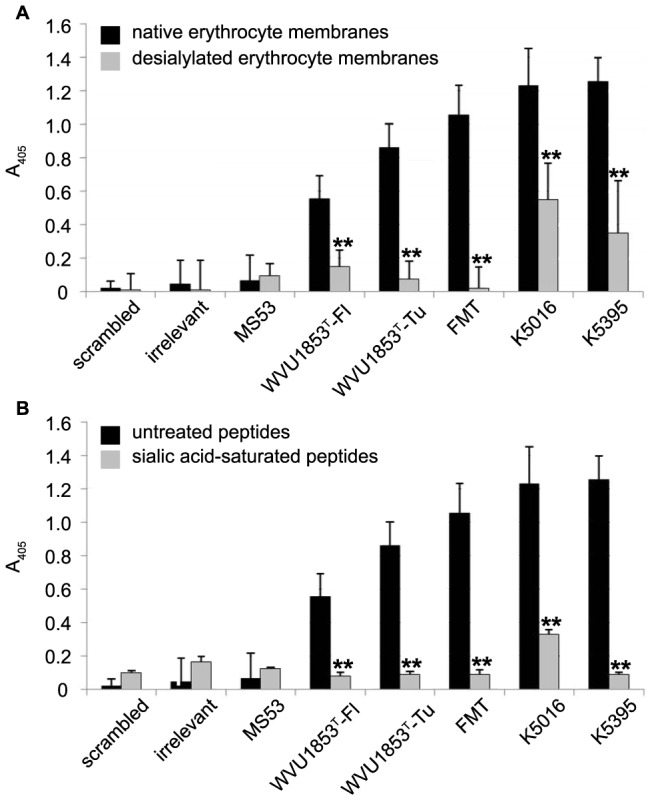
Effects of sialylation and desialylation on PHM peptide binding.Bars depict mean ± standard error of the amount of synthetic peptide bound to avian erythrocyte membranes in an ELISA format (n = 3 independent replicates, with duplicate measurements of each peptide within replicate). (A) Desialylation of erythrocyte membranes significantly reduced PHM peptide binding relative to native membranes (**  = P<0.01) for all strains of M. synoviae except MS53, which bound to native or desialylated erythrocyte membranes at background levels. (B) Presaturation of PHM peptides with free sialic acid before exposure to native erythrocyte membranes significantly reduced binding relative to untreated peptides (**  = P<0.01) for all strains except MS53, on which sialic acid had no effect.